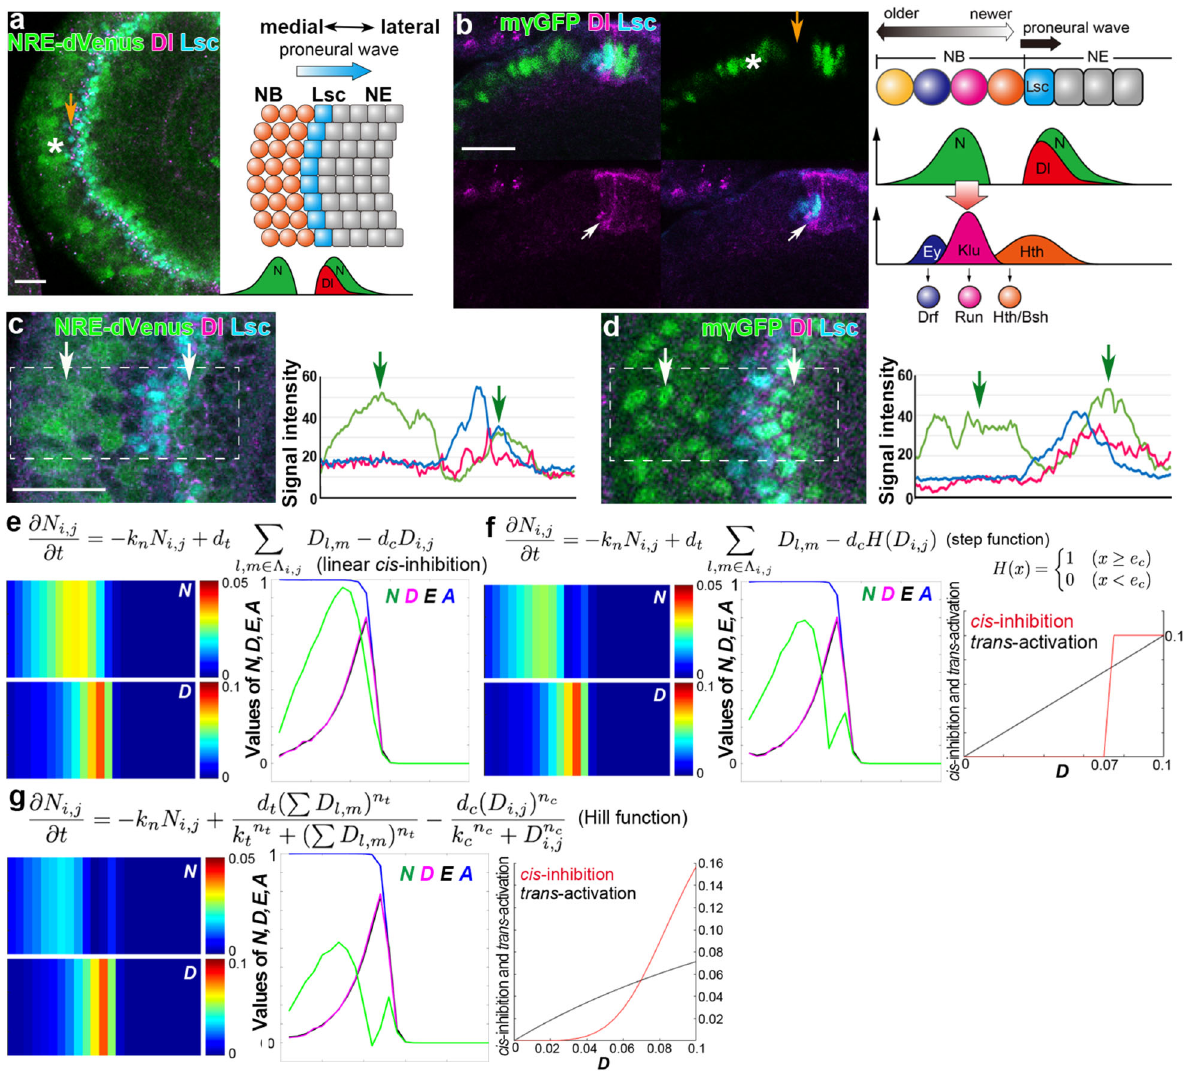
Fig. 1 Nonlinear cis -inhibition establishes the twin peaks of Notch activity. a Optic lobe in a lateral view showing the twin peaks of Notch activity (NRE- dVenus, green), wavefront (Lsc, blue), and Dl (magenta) in the left panel. The proneural wave progresses in a medial-to-lateral orientation (left to right). Asterisk indicates the second peak of N activity in NBs. Orange arrow indicates the gap between the twin peaks. The right panel shows that Lsc expression at the wavefront triggers the differentiation from NE to NB and overlaps with Dl expression and the fi rst peak of N activity. b A section showing the twin peaks of Notch activity (m γ GFP, green), wavefront (Lsc, blue), and Dl (magenta). White arrows show Dl expression at the wavefront. Orange arrow indicates the gap between the twin peaks of N activity. Schematic shows that NBs sequentially express temporal transcription factors, Hth (orange), Klu (magenta), and Ey (blue), which control the production of neurons expressing Hth/Bsh, Run, and Drf, respectively. c , d N activity is visualized by NRE- dVenus ( c ) and m γ GFP ( d ) in green and compared with the distributions of Dl (magenta) and Lsc (blue). Signals in the dotted box areas are plotted in the right panels. Arrows indicate the twin peaks of N activity. Scale bars indicate 20 μ m ( a – d ). e – g Results of numerical simulations: left panels show the two- dimensional patterns of N and D . Middle panels show the one-dimensional patterns of N (green), D (magenta), E (black), and A (blue; y = 13). The values of N , D , and E are 30, 10, and 10 times multiplied, respectively. Right panels in ( f , g ) compare the pro fi les of trans -activation (black) and cis -inhibition (red) in response to D . The values of trans -activation are four times multiplied because one cell could receive trans -activation from as many as four adjacent cells. e Single peak of N activity in the previous mathematical model in which the effect of cis -inhibition is linear. f , g Twin peaks of N activity are reproduced by introducing step function ( f ) or Hill function ( g ) to cis